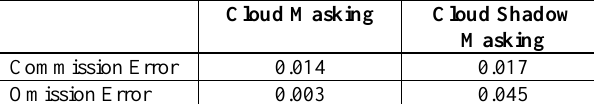
Table 3. Commission error and omission error of cloud and cloud shadow masking using MCM algorithm Cloud